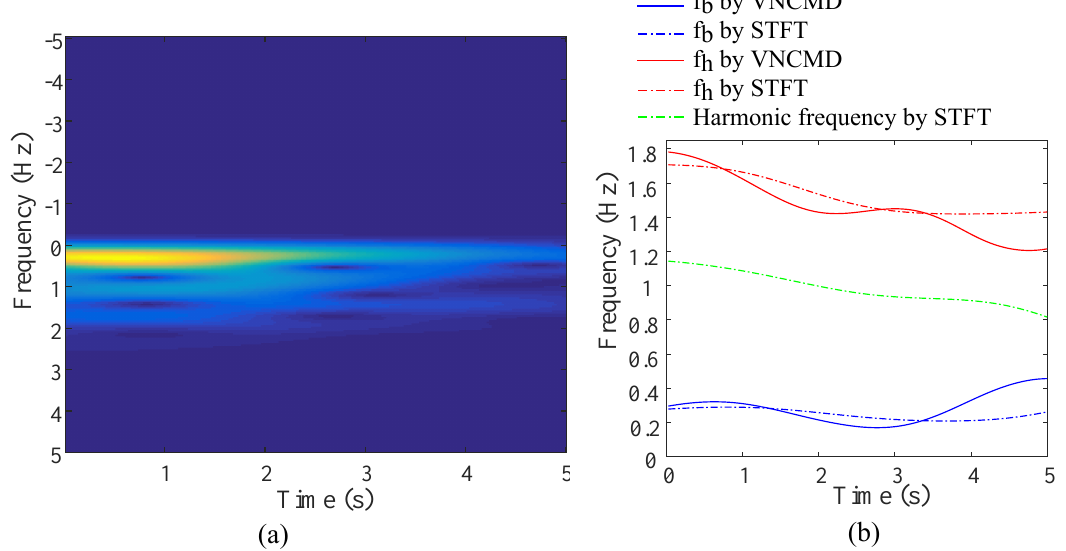
Figure 7. ( a ) Results of short time Fourier transform (STFT), and ( b ) extracted frequencies by STFT and variational nonlinear chirp mode decomposition